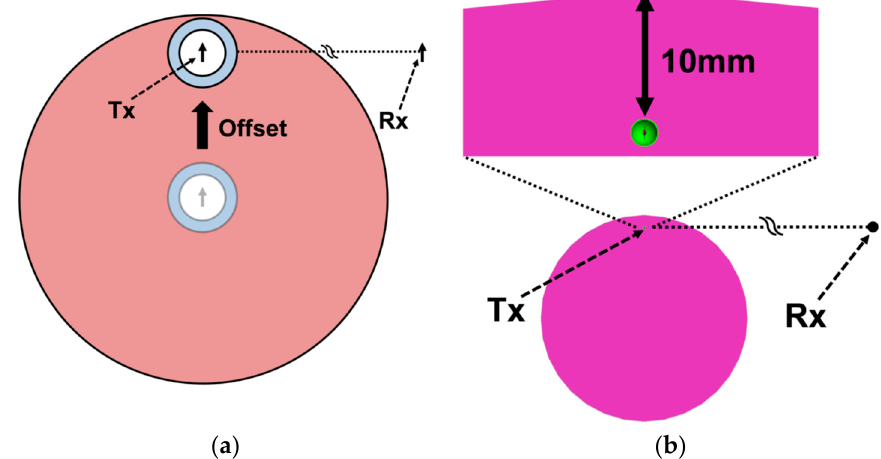
Figure A1. Off-center Tx model: ( a ) conceptual diagram; ( b ) model used for FEKO simulation. Figure A1. O ff -center Tx model: ( a ) conceptual diagram; ( b ) model used for FEKO